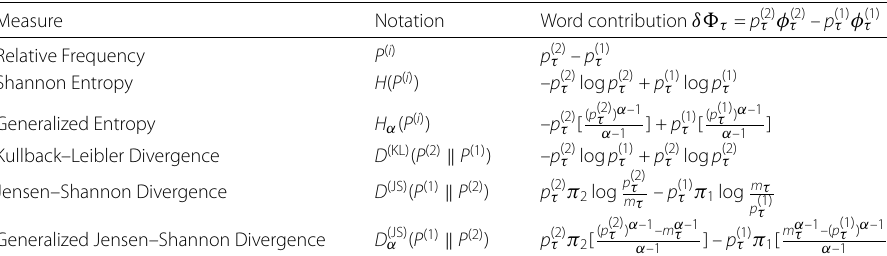
Table 1 Contributions and scores of various text comparison measures according to the word shift framework. The word contribution δ(cid:6) τ indicates how an individual word impacts a measure, and each contribution is expressed as a difference in weighted averages so that it can be easily identified with the components of the word shift framework Measure Notation Word contribution δ(cid:6) τ = p (2) τ φ (2) τ – p (1) τ φ (1) τ Relative Frequency P ( i ) p (2) τ – p (1) τ Shannon Entropy Generalized